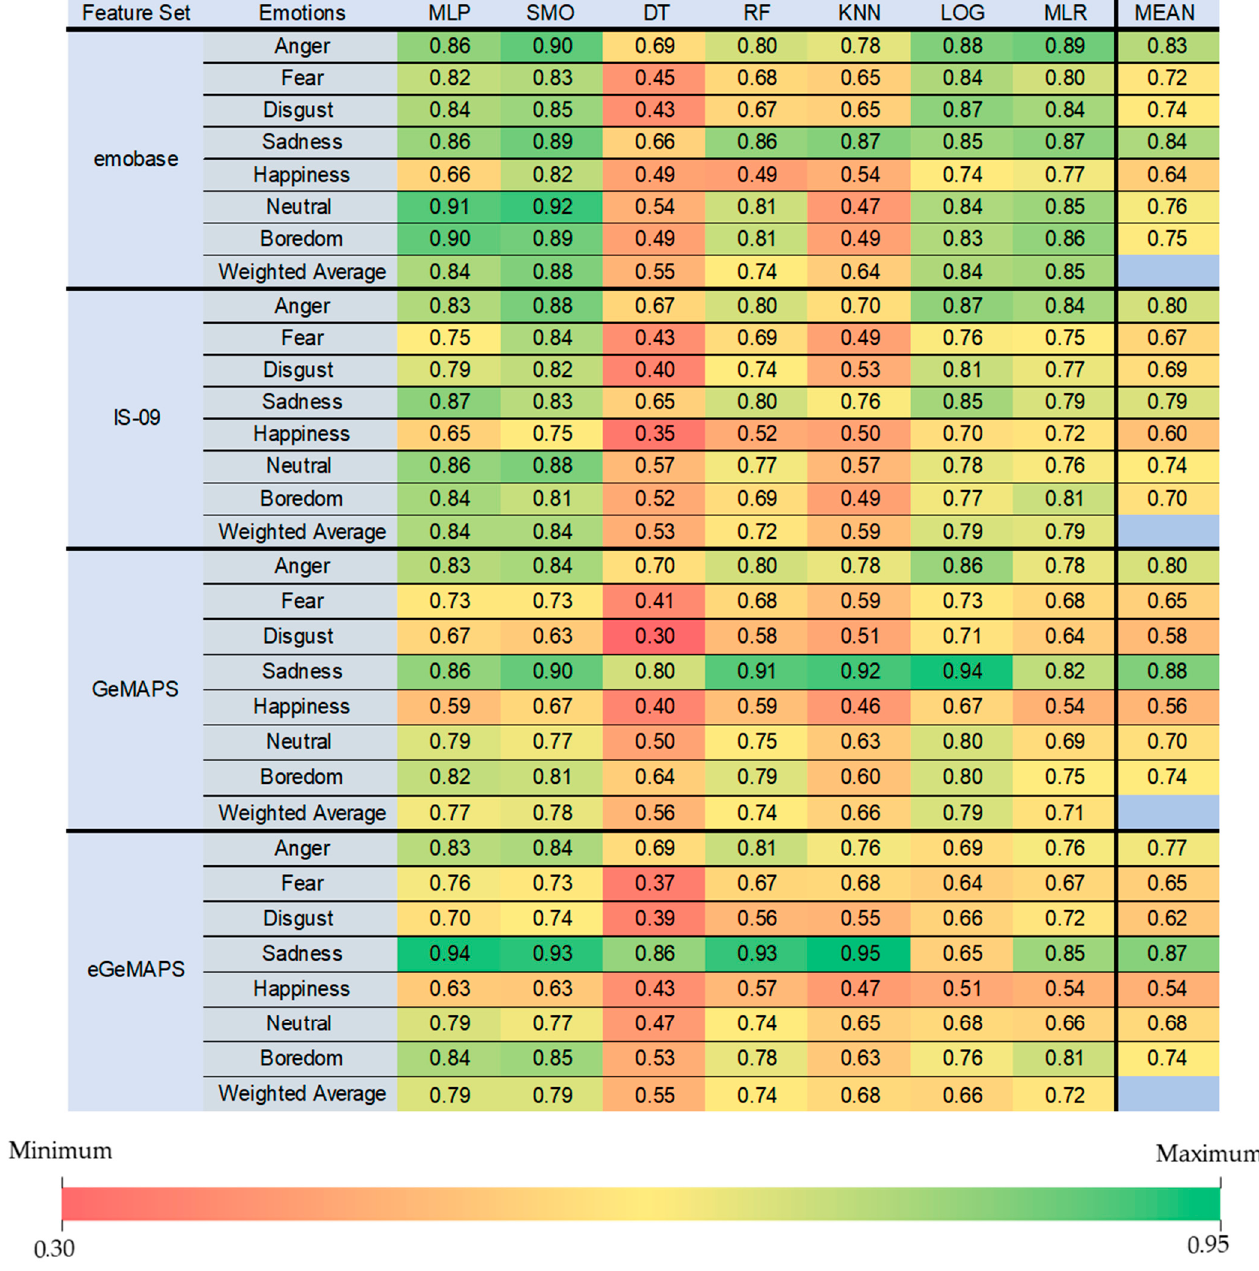
Figure 3. F-measures for each emotion. Color coding indicates performance, with dark green indicating best and dark red indicating poorest performance, and with yellow indicating intermediate classification performance, as shown in the color bar.